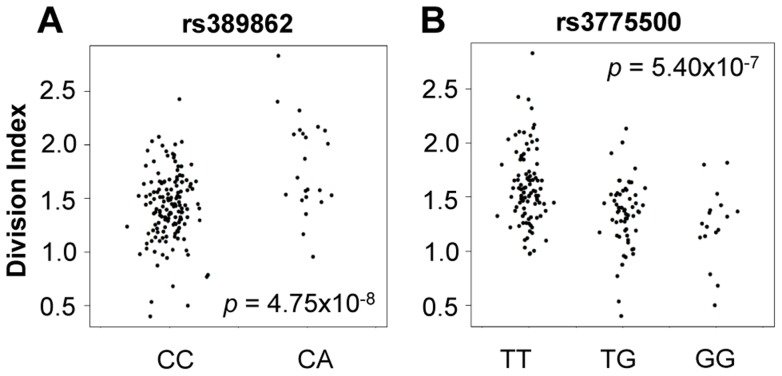
Genome-wide association to division index (the average number of division undergone by all cells).
A) rs389862A on chromosome 13 was significantly associated to increased division index at p = 4.75×10−8, and is located in a non-coding region 30 kb upstream of RASA3, and 70 kb upstream from CDC16. B) rs3775500G on chromosome 4 shows a strongly suggestive association at p = 5.40×10−7, and is located within the DAPP1 (Bam32) gene.